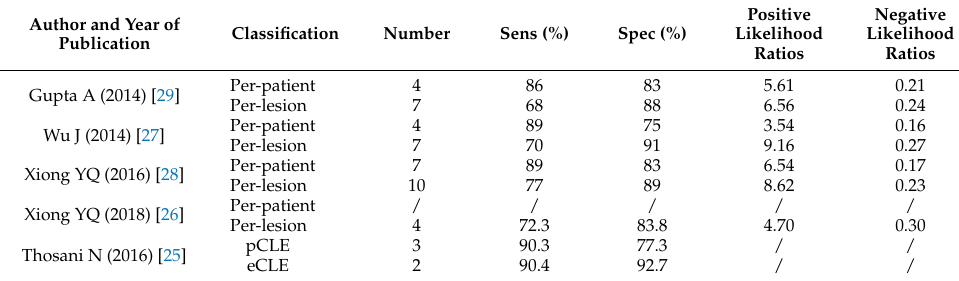
Table 1. Meta-analyses of Barrett’s